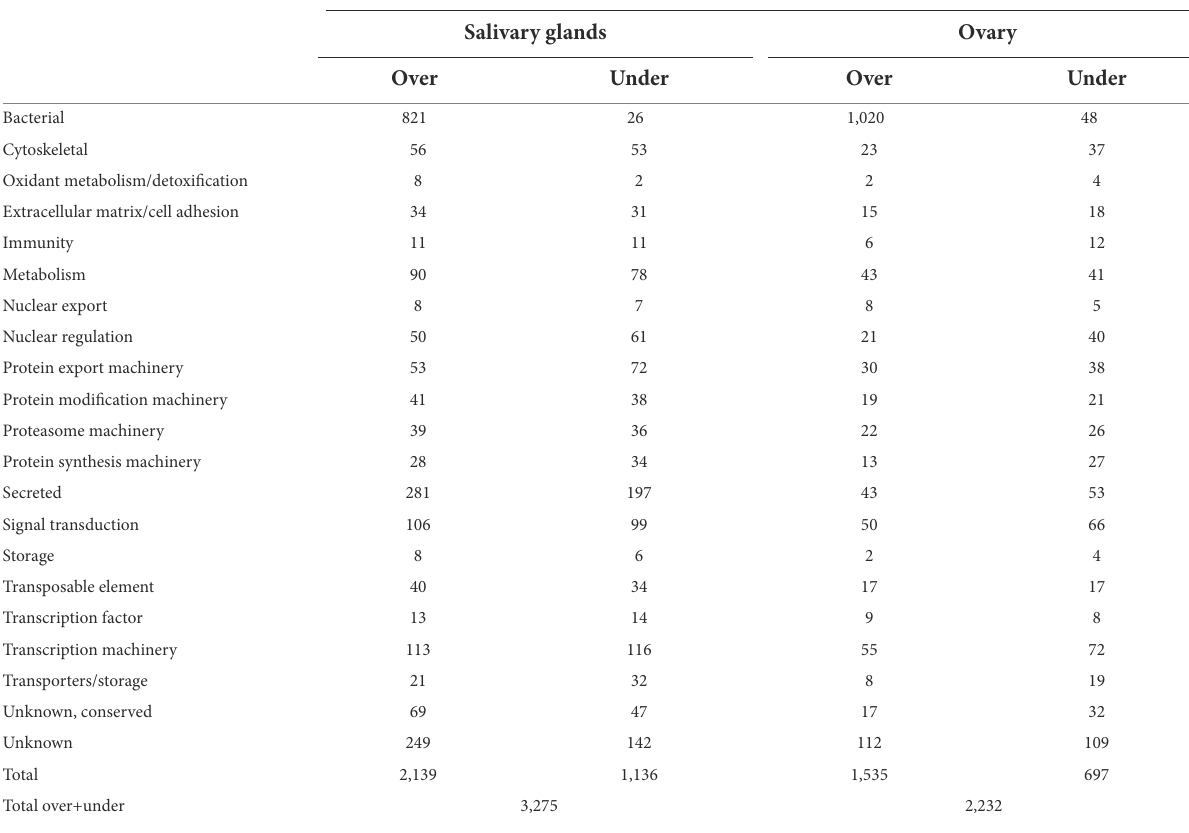
TABLE 1 Differentially expressed transcripts (DET– at least 8 fold over or underexpressed and with a false discovery rate of 0.05 or lower) from A . maculatum ovary and salivary glands in response to R . parkeri infection grouped into functional categories. Functional